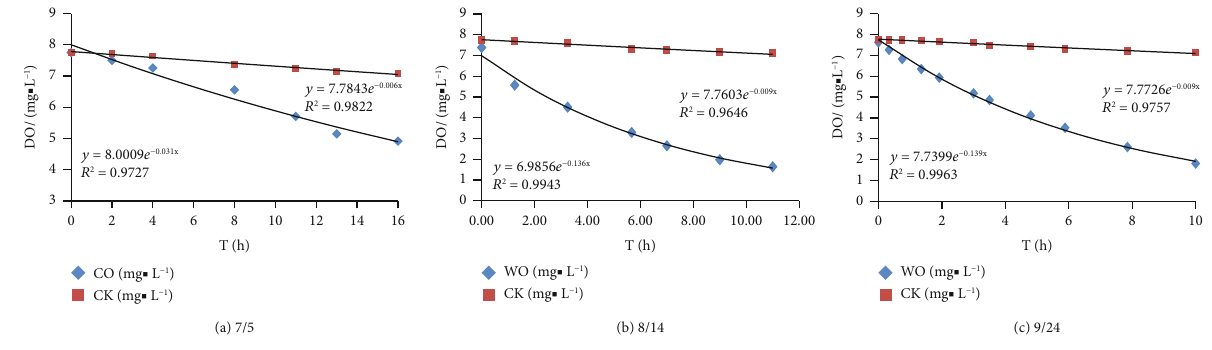
Figure 1: Changes of dissolved oxygen in culture medium in di ff erent periods (mg · L -1 ).